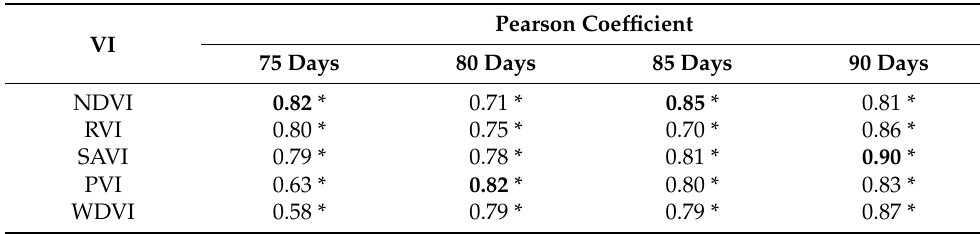
Table 5. The Pearson coefficient representing the relationships between the derived VIs and the yield of the Faber hybrid.